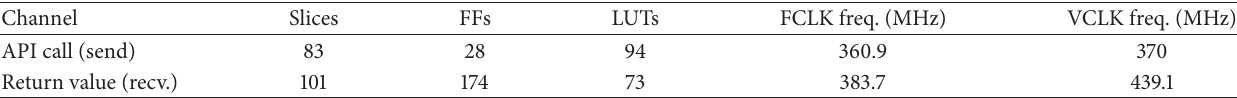
Table 5: Management API Call Channel—synthesis results.